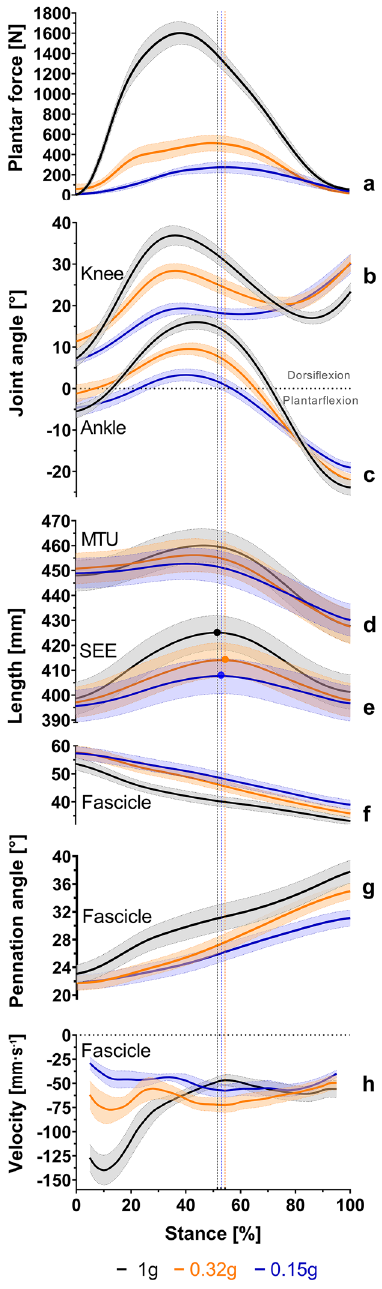
Figure 1. Kinetic, kinematic, gastrocnemius medialis fascicle and series elastic element parameters during the stance phase of running at 1 g, simulated Martian gravity and simulated Lunar gravity. Participants’ average (mean ± standard error) patterns of plantar forces ( a ), knee ( b ) and ankle ( c ) joint angles, and muscle ‒ tendon unit ( d ) and series elastic element ( e ) lengths as well as muscle fascicle lengths ( f ), pennation angles ( g ), and velocities ( h ) change during the stance phase of running at 1 g (black line), simulated 0.32 g (orange line), and 0.15 g (blue line). The vertical dashed lines mark the point of time at which peak series elastic element length was achieved (in % of stance) at 1 g (black), simulated 0.32 g (orange), and 0.15 g (blue). Please note that the observed hypogravity levels were slightly lower than the actual values for Martian and Lunar gravity. Means and standard errors of the 1 g condition have previously been published by Richter et al. 19 . n = 8